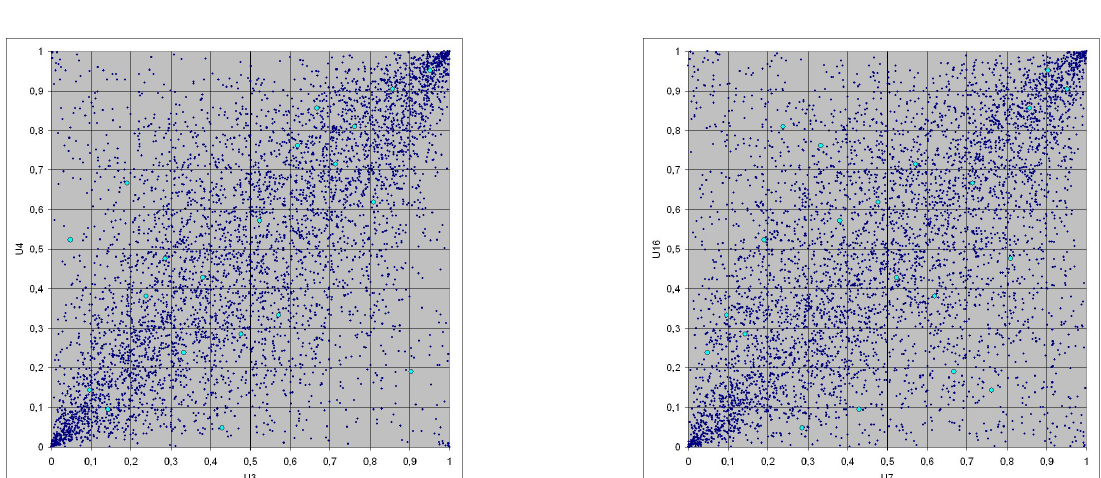
Figure 34: t -copula with two degrees of freedom, I